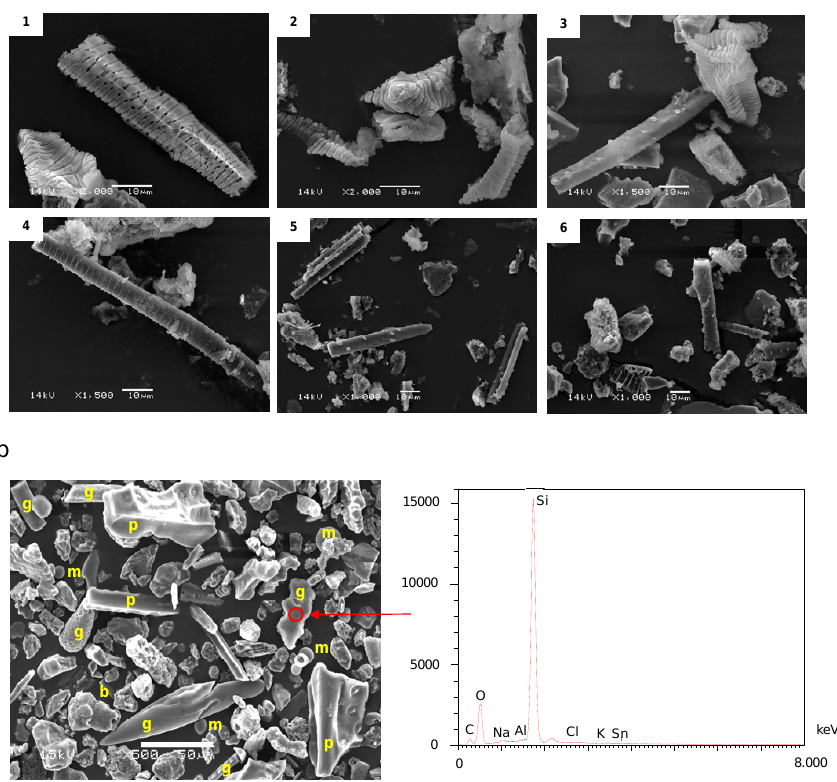
Fig. 2. (a) SEM micrographs of opal phytoliths in Fagus sylvatica litterfall (1, 2, 3 leaves, 4, 5 bud scales, 6 fruit capsules), scale bars at all micrographs=10µm; (b) SEM micrographs of opal phytoliths in AE horizon, 0–2cm, scale bar=50µm (b=beech, p=pine, g=grass,